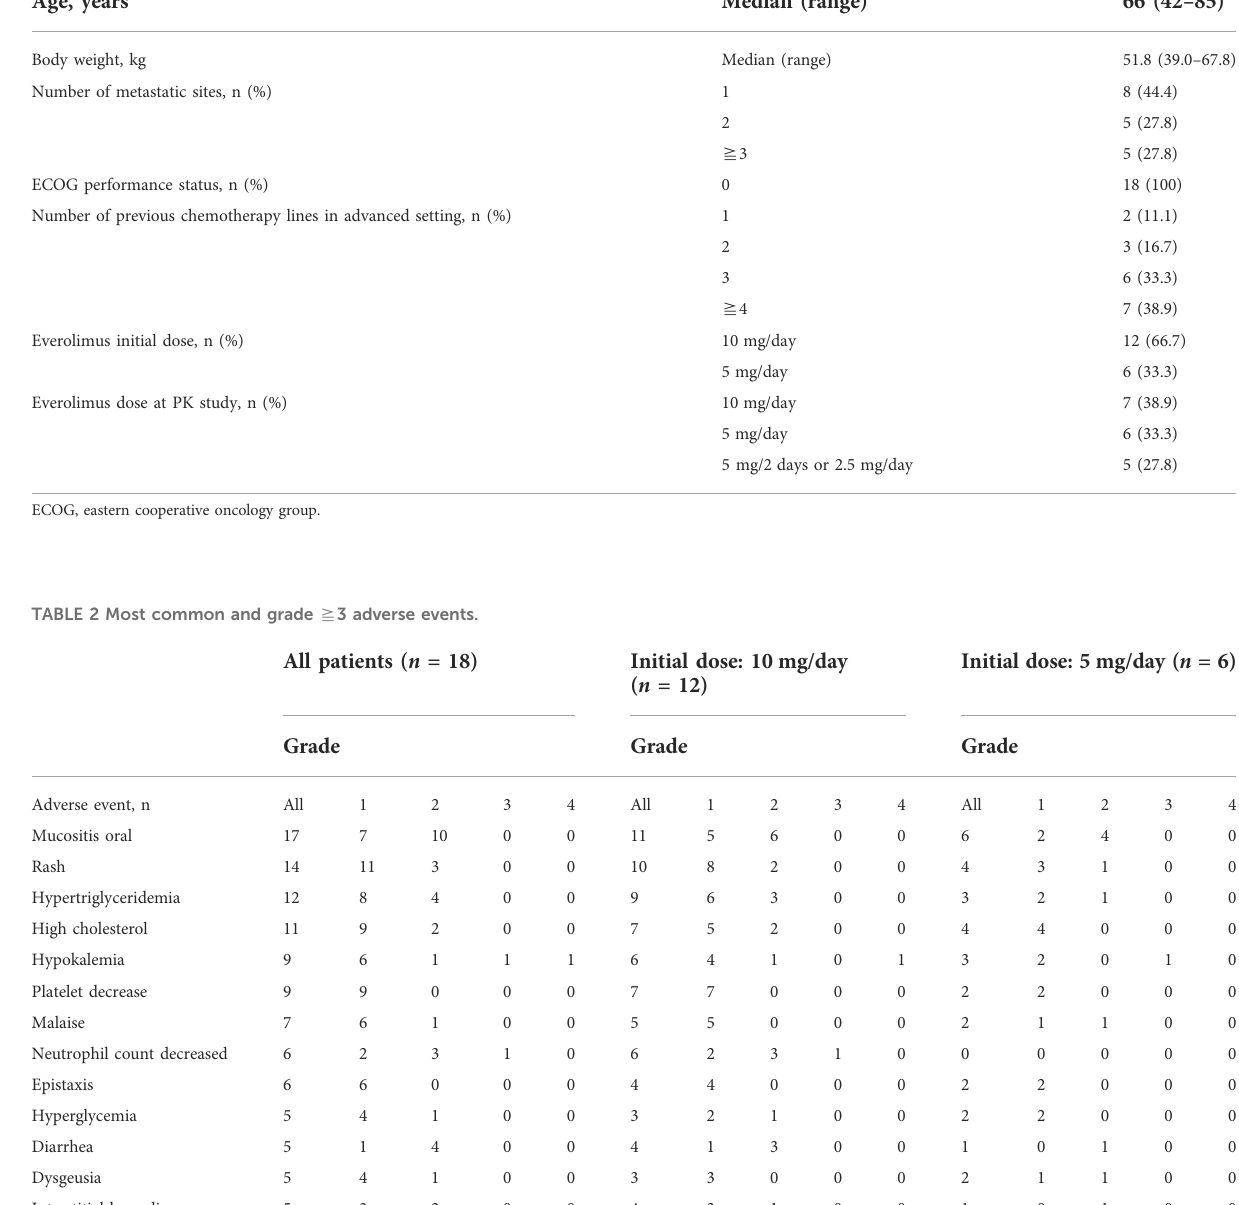
TABLE 1 Baseline patient characteristics.